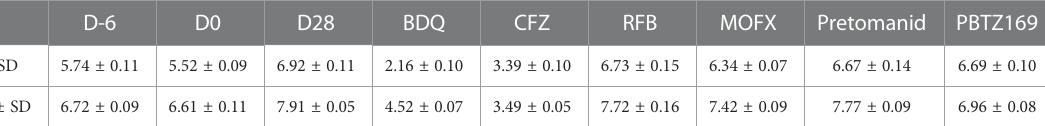
TABLE 3 M.avium burden in the lungs and spleens of mice.